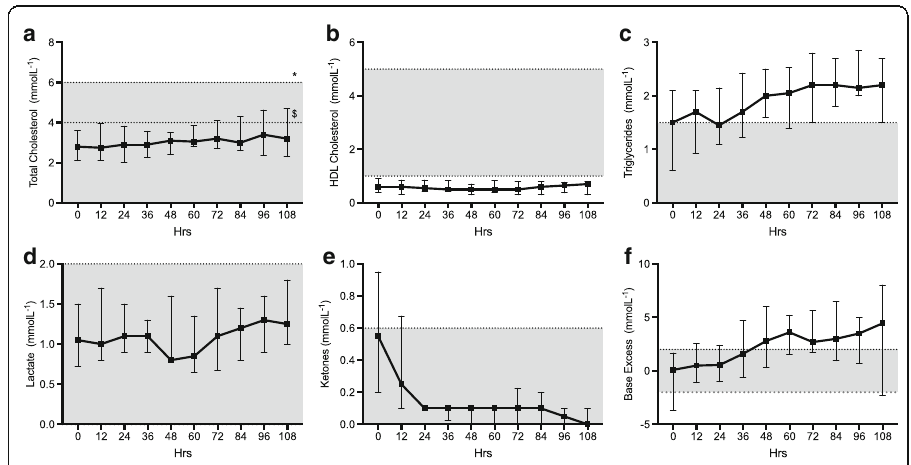
Fig. 4 Metabolic profile. Median and interquartile range for each time point. Normal range is represented by the shaded area. a total cholesterol, b HDL cholesterol, c Triglycerides, d lactate, e ketones, f base excess. * upper limit for individuals at low cardiovascular risk. $ upper limit for individuals at high cardiovascular